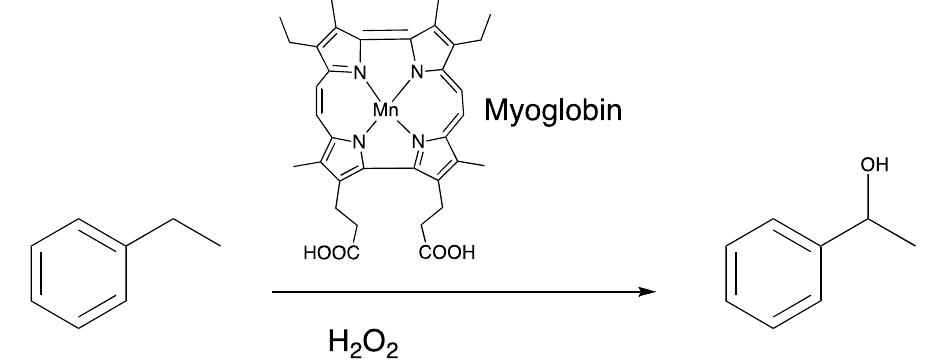
Figure 9. MnPorphycene (MnPc) substituted myoglobin and its reactivity towards a C(sp 3 )–H bond. (turnover number) of 13 and kinetic isotope effect of